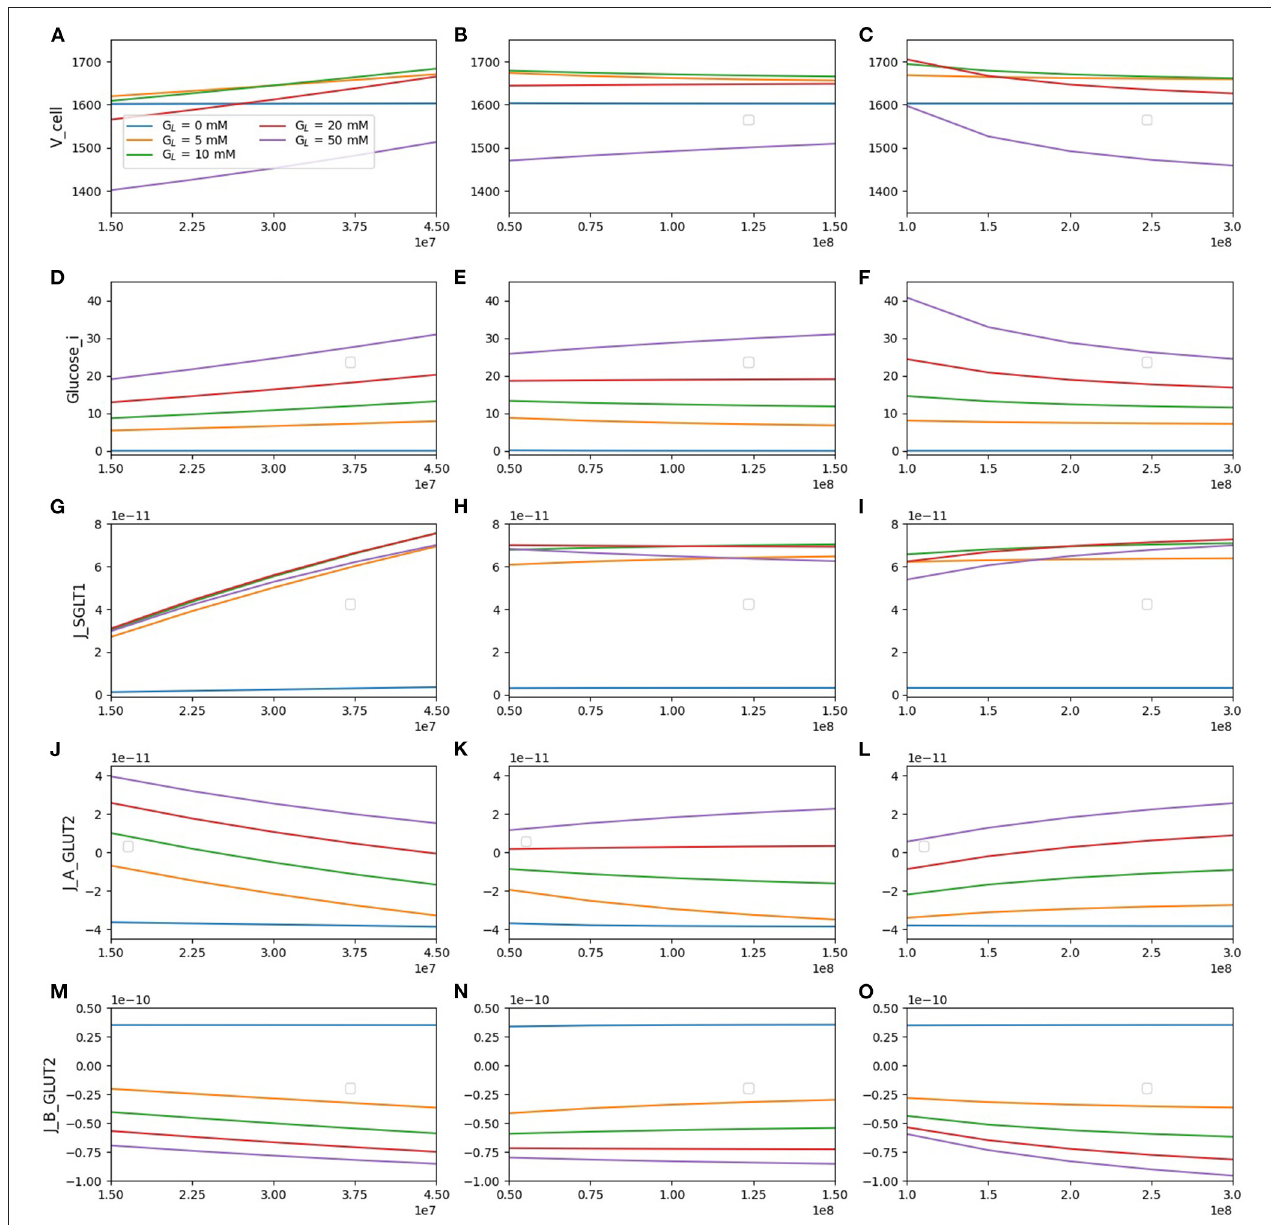
FIGURE 6 | Model response to different transporter densities. (A–C) Cell volume; (D–F) intracellular glucose; (G–I) SGLT1 glucose flux; (J–L) apical GLUT2 flux; (M–O) basolateral GLUT2 flux. In each column, one transporter density is varied while the other two are held constant at the reference value [nSGLT1 = 3 × 10 7 , nGLUT2 (apical) = 10 8 , nGLUT2 (basolateral) = 2 × 10 8 ]. flux reduces by about 20% and basolateral flux by about